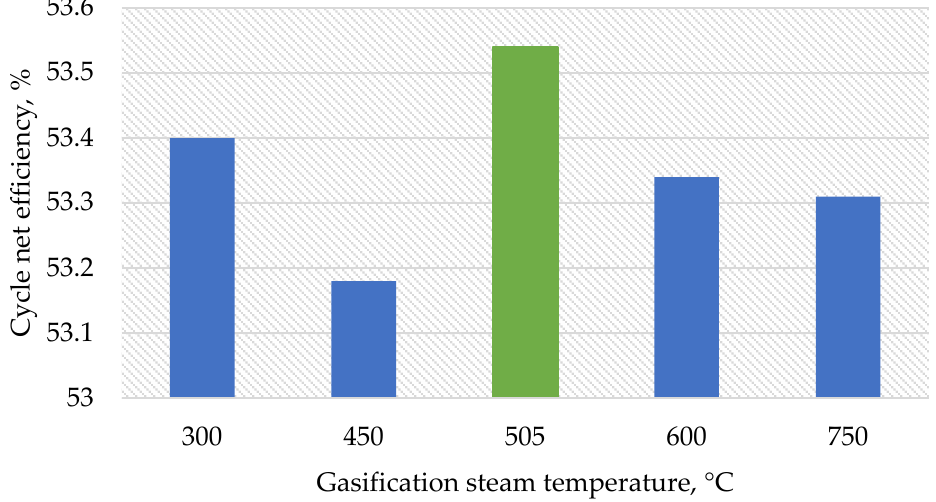
Figure 7. Relationship of the cycle net efficiency to the gasification steam temperature. The cycle efficiency is verified within 0.5%. Among the reviewed versions, the 505 ◦ C steam bleeding from the turbine has the highest efficiency, and the cycle with 450 ◦ C has the lowest efficiency. Small differences in the cycle efficiency values, depending on the steam temperature, are primarily due to the low dependence of the syngas combustion heat on the steam temperature. The change in the required steam flow rate in the gas generator on its temperature leads to the fact that the dependence of the cycle efficiency on the blast temperature has a non-linear